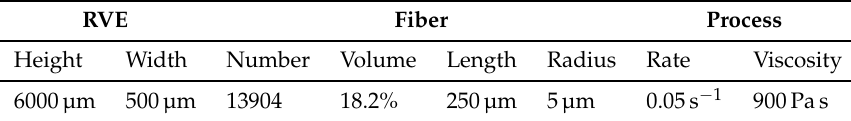
Table 6. Simulation settings for the virtual elongational test for PP-GF30.